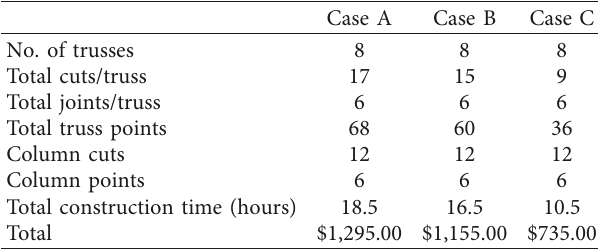
Table 6: Summary of truss predelivery